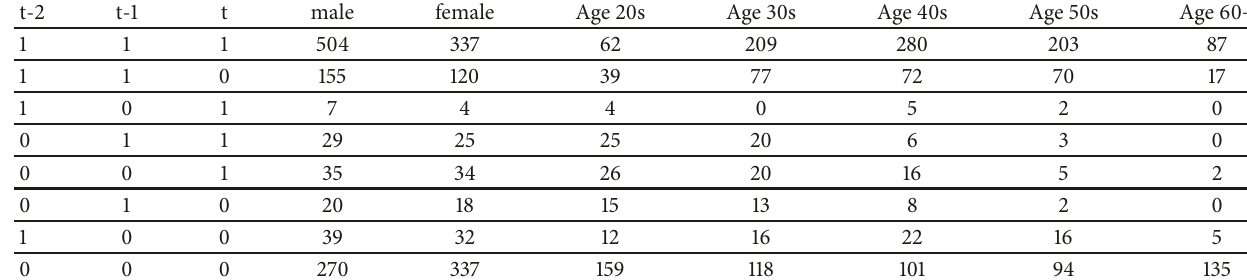
Table 3: Car use status over time from (t-2) to (t).